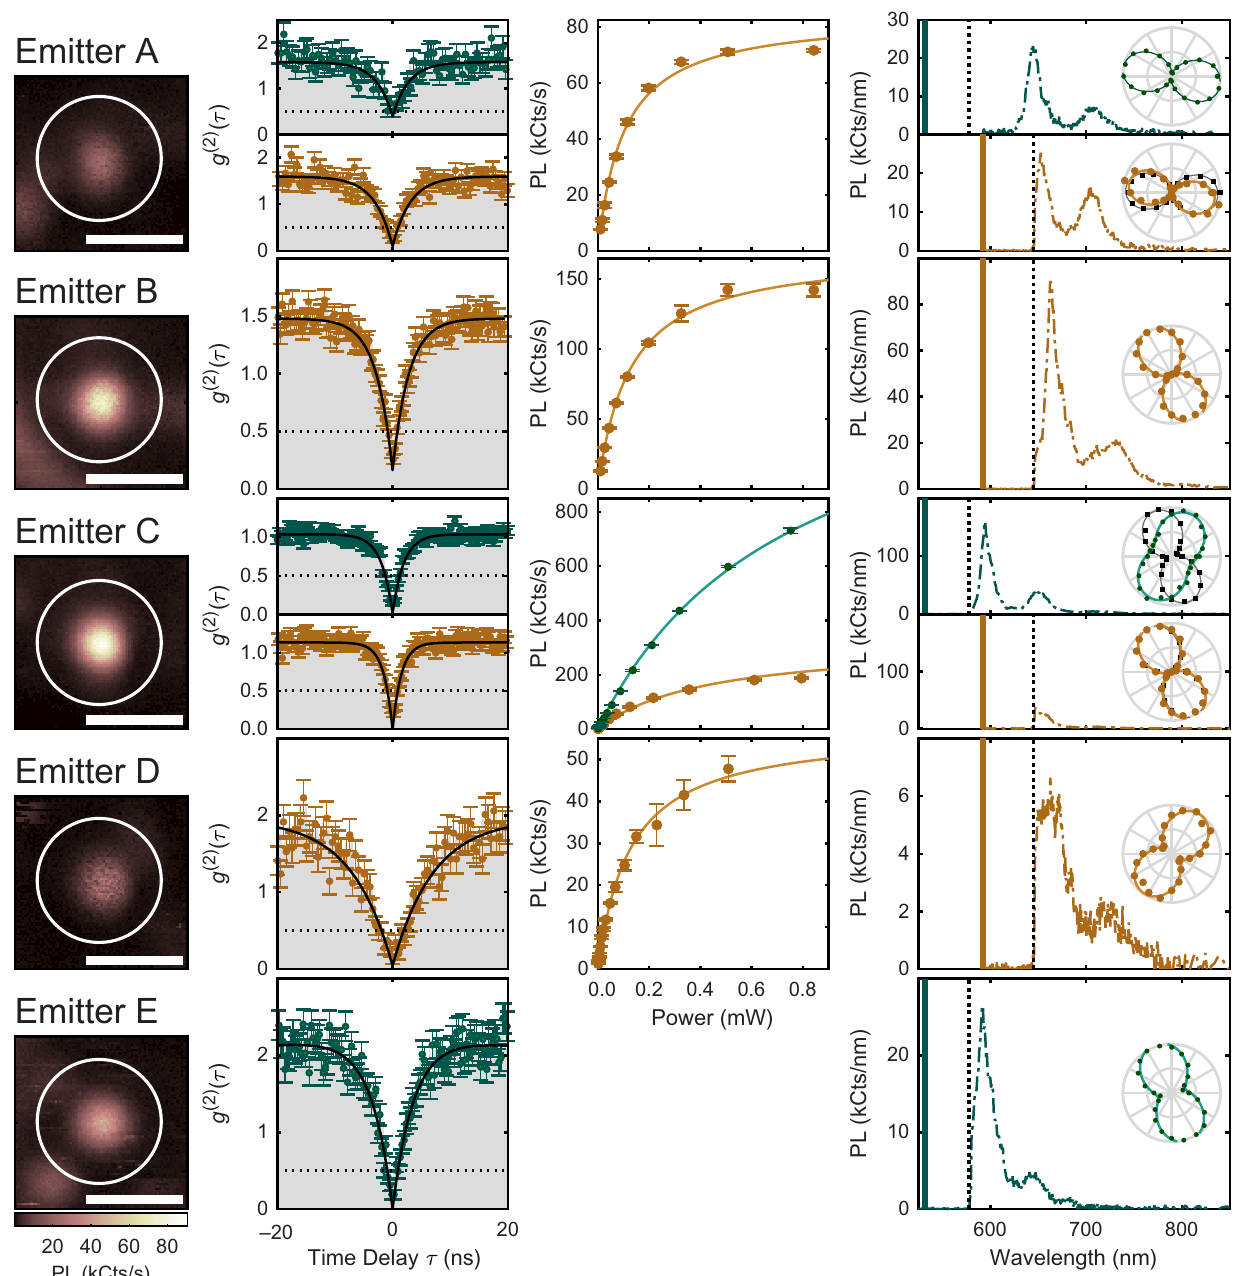
FIG. 1. Photoluminescence characterization. In all panels, data plotted in green (orange) are acquired under 532 nm (592 nm) excitation. (Column 1) The μ -PL images of the QEs (circled), acquired under 592 nm (QEs A–D) or 532 nm (QE E) excitation. Scale bars denote 1 μ m. (Column 2) Second-order photon autocorrelation function (colored points), fit using an empirical model discussed in the text (black curve). Error bars represent Poissonian uncertainties based on the photon counts in each bin. (Column 3) Steady-state, background-subtracted PL intensity as a function of excitation power (points), fit using an empirical saturation model discussed in the text (solid curves). Saturation data for QE E are missing since the QE disappeared before the measurement could be performed. Error bars represent one standard deviation based on three measurement repeats. (Column 4) PL spectra and polarization data. Vertical colored lines represent the excitation laser wavelengths, and black dotted lines indicate cut-on wavelengths for long-pass optical filters in the collection path. Insets: PL intensity as a function of the linear excitation polarization angle (colored circles) or filtered by the linear polarization angle in emission (black squares). Solid curves are fits to the data using an empirical model discussed in the